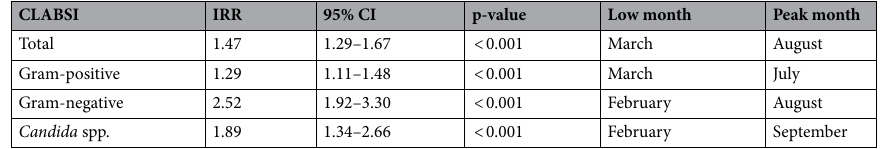
Table 3. Mixed-effects regression analysis of peak-to-low incidence rate ratio seasonality. Mixed-effects negative binomial regression model that calculated the adjusted incidence rate ratio (IRR) using hospital units as random effects and other covariates such as year, month and university-affiliation as categorical fixed effects. Incidence rate ratios are expressed as a peak-to-low ratio between the lowest incidence rate to the respective peak month per pathogen.